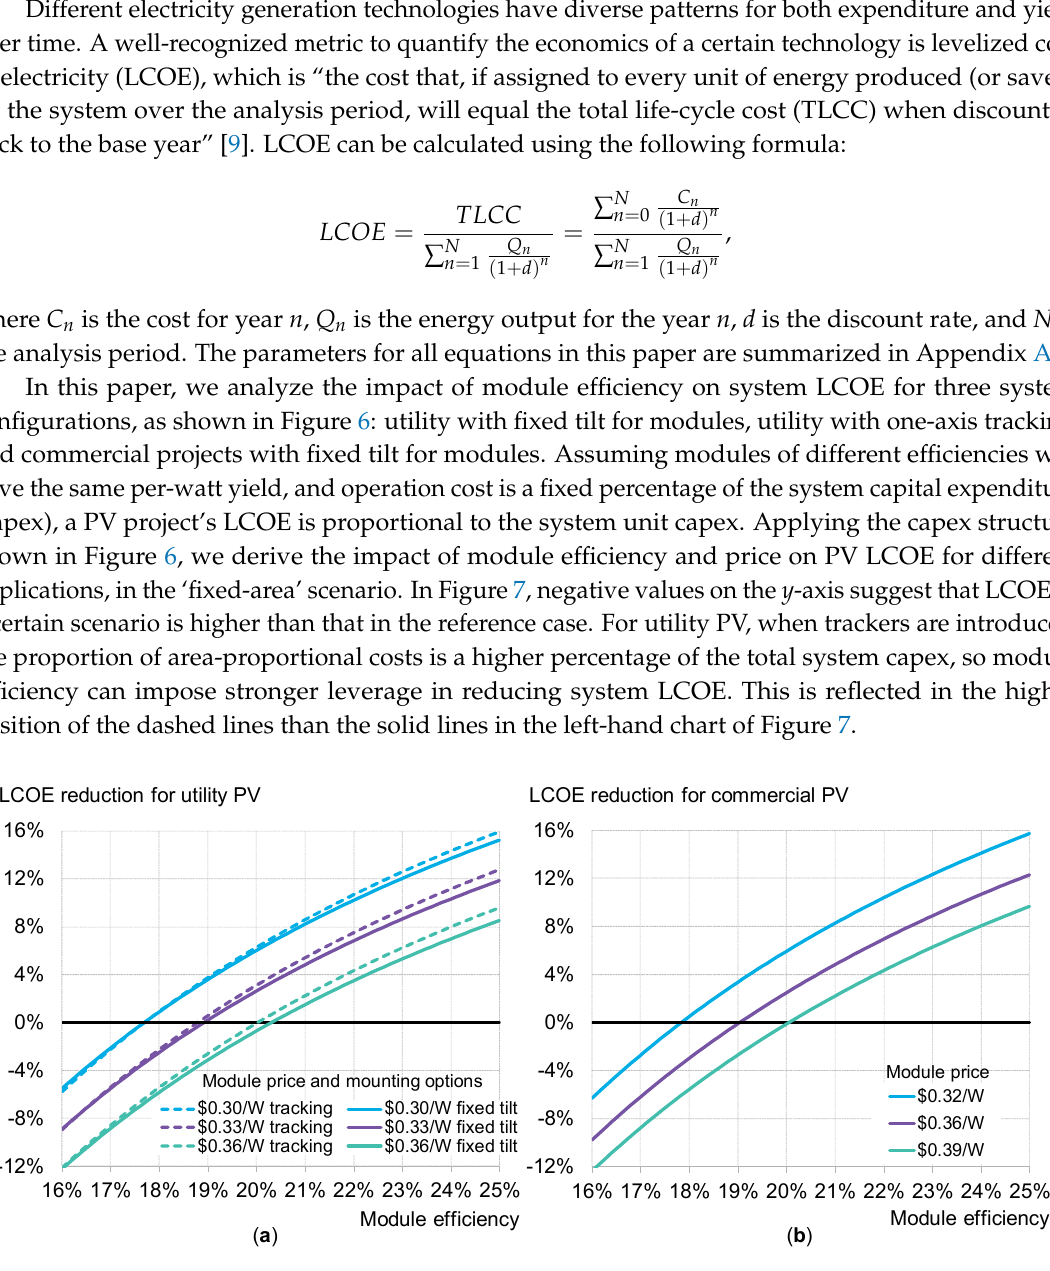
Figure 7. Sensitivity of PV LCOE to module price and efficiency for ( a ) utility applications and ( b ) commercial applications. Note: The analysis is for cases without restriction on power capacity. ‘Tracking’ here assumes that one-axis horizontal trackers are adopted.